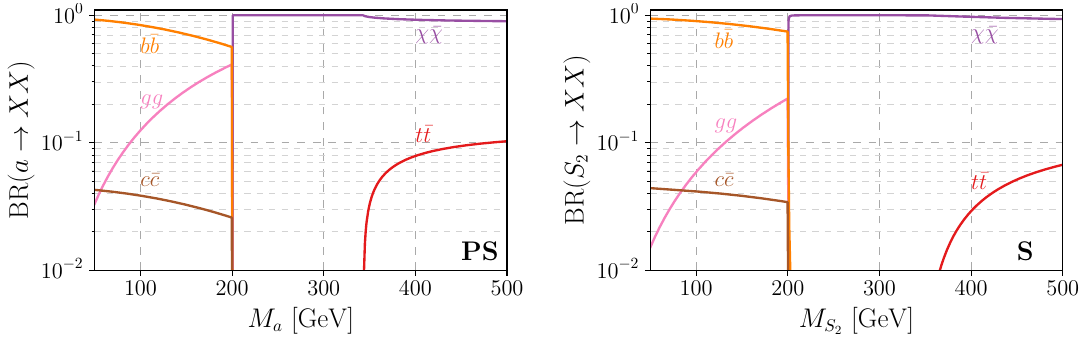
Figure 2 . Dominant branching ratios of the light pseudoscalar a in the 2HDM+PS (left) and the light scalar S 2 in the 2HDM+S (right) for tan (cid:12) = 1, m (cid:31) = 100 GeV (to show more decay channels), M = M = M A = 500 GeV and other parameter values as given in eq. H=S 1 H (cid:6)